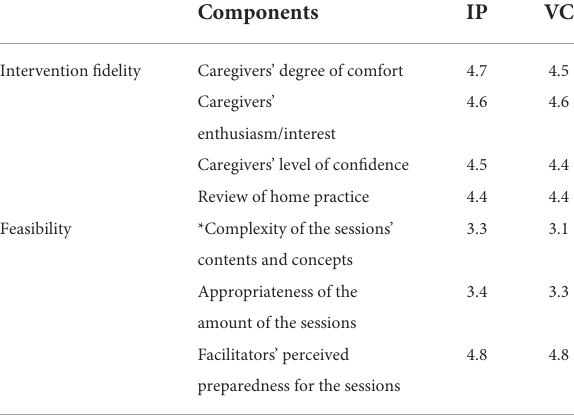
TABLE 7 Average ratings on the intervention fidelity and feasibility of group sessions’ delivery.